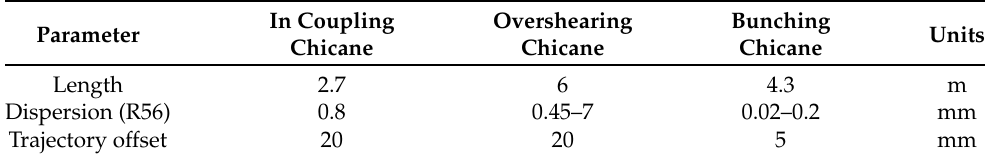
Table 5. Parameter for the 3 chicanes required for the